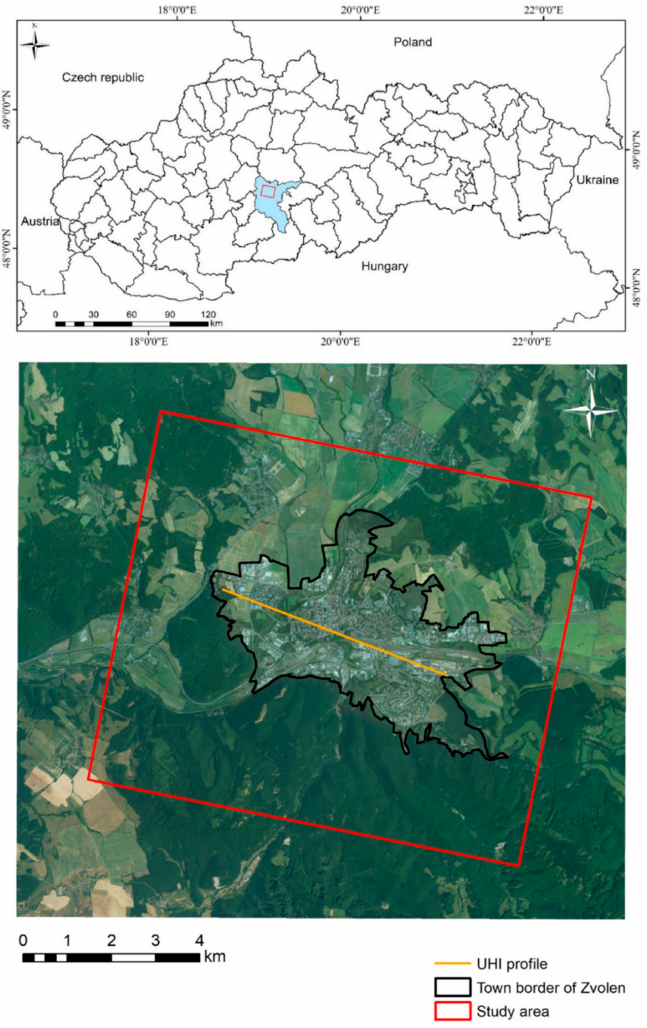
Figure 1. Location of the study area. Note: The town boundary separates the urban zones and the open